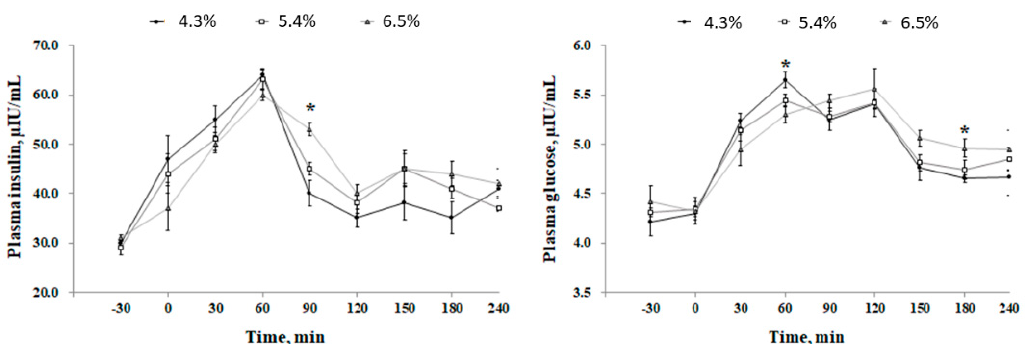
Figure 3. Effect of dietary acid detergent fiber levels in gestation diets on plasma insulin and glucose (d 112). Values represent means ± standard error. Asterisks (*) indicate statistical significance ( p < 0.05).